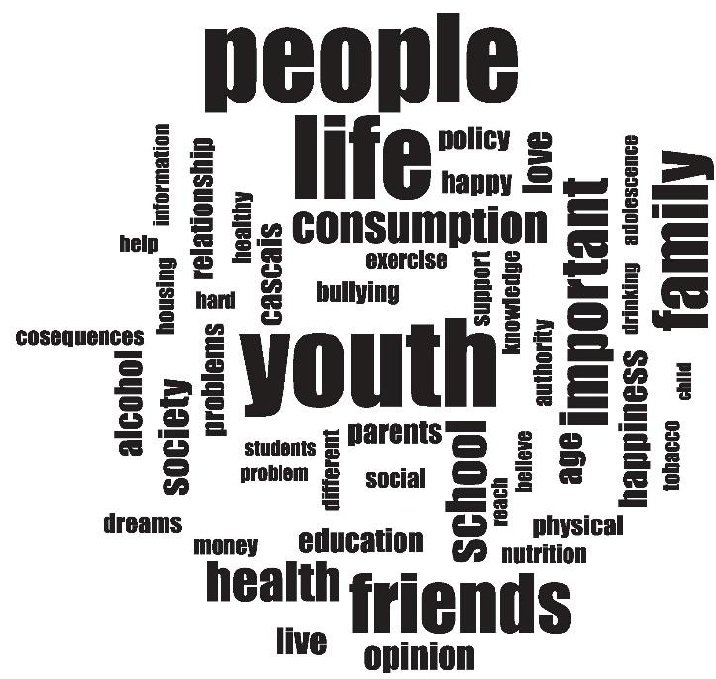
Figure 3. Word Cloud [Reprinted from Branquinho et al., 2021; [32]].